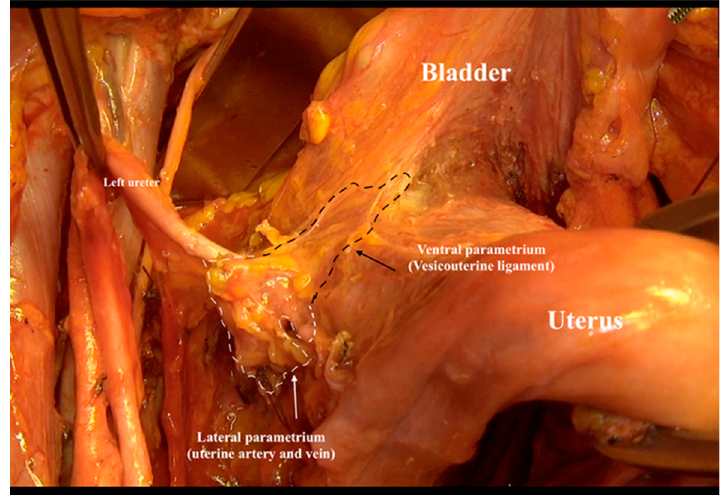
Figure 4. Resection of the uterine artery and vein (lateral parametrium) at the internal iliac artery and vein.